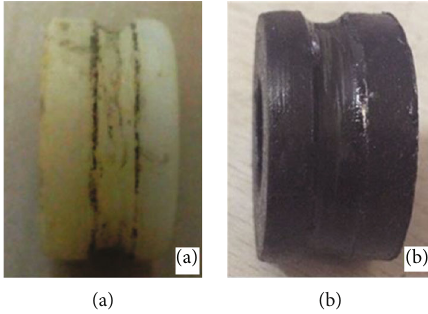
Figure 13: (a) Inner ring of nylon bearing. (b) Inner ring of GO- GFN